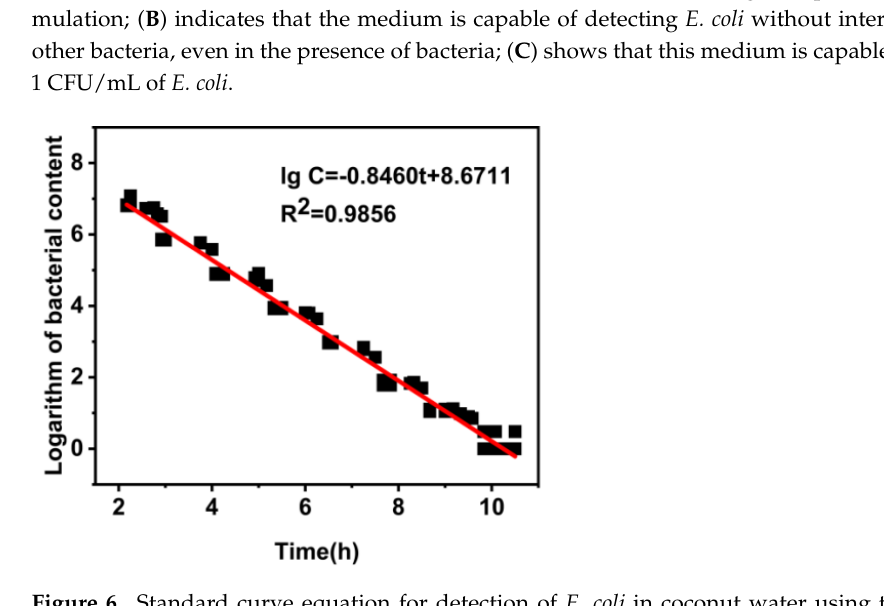
Figure 6. Standard curve equation for detection of E. coli in coconut water using the microbial photoelectric detection